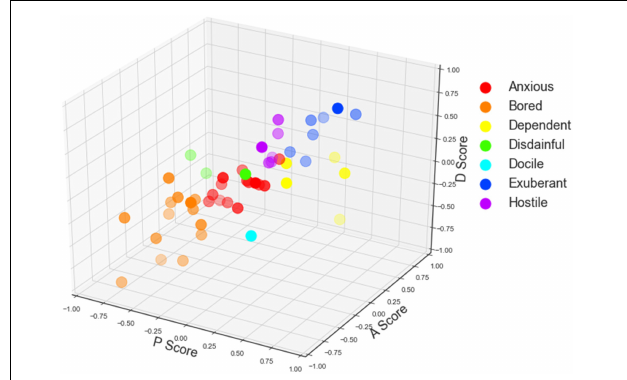
FIGURE 5 | The scatter plot of participants’ Pleasure-Arousal-Dominance (PAD) scores of the interaction quality.